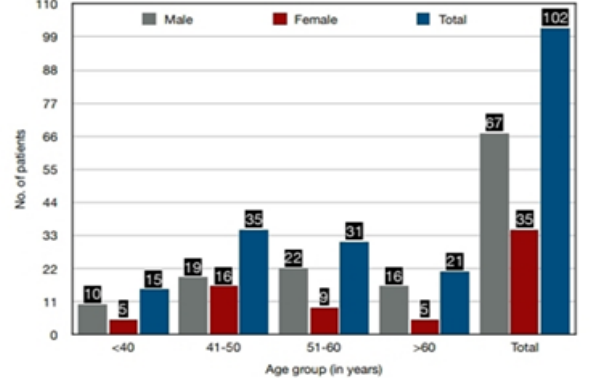
Fig 1. Age and gender wise distribution of the patients (n=102).